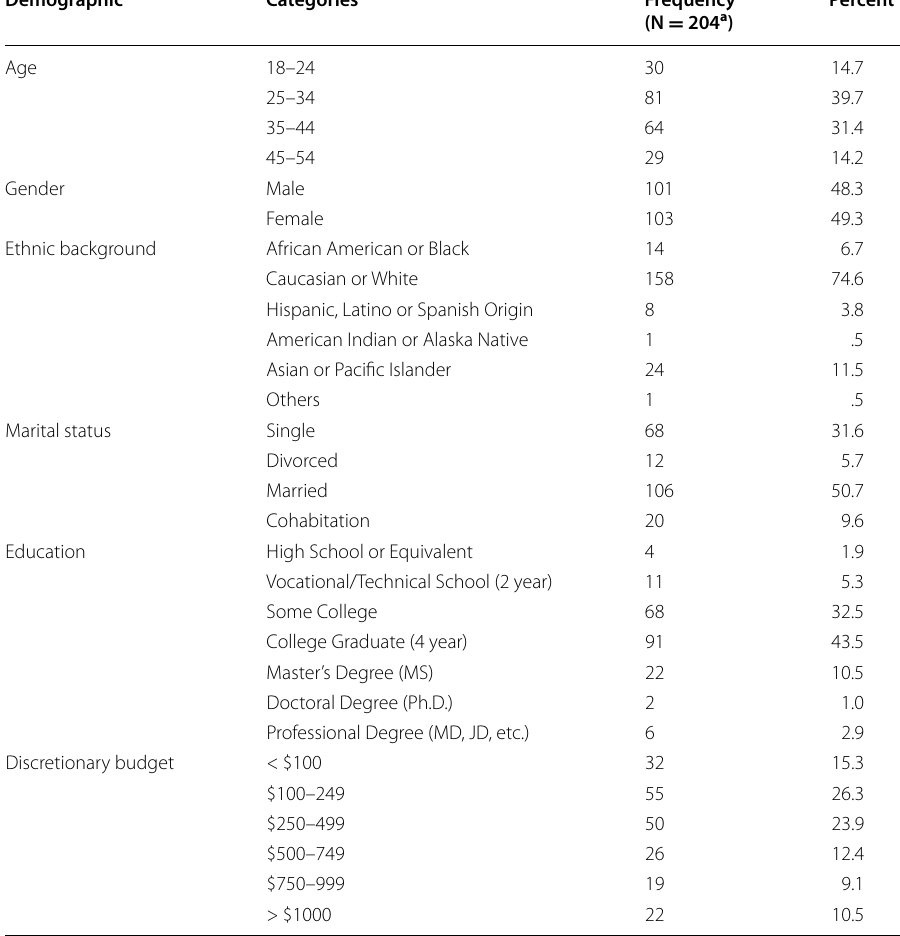
Table 2 Demographic